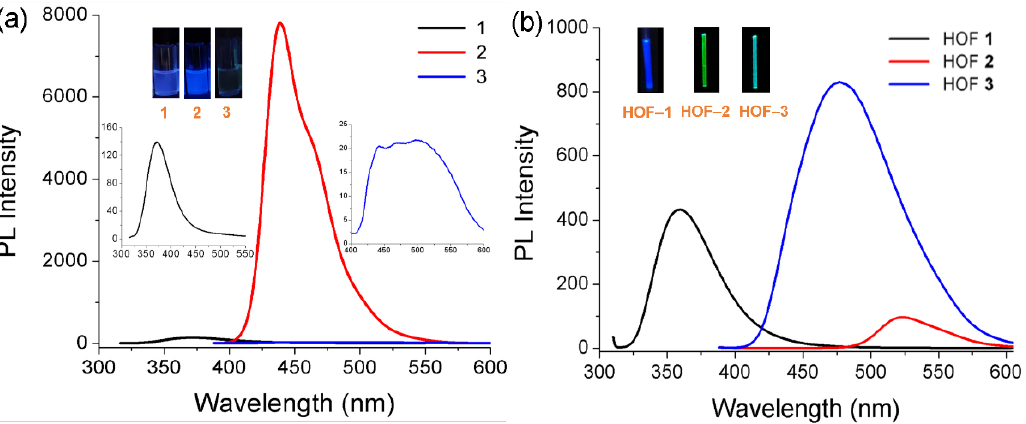
Figure 5. Emission spectra of 1 , 2 , and 3 and HOF-1 , HOF-2 , and HOF-3 . ( a ) PL spectra of 1 (black), 2 (red), and 3 (blue) in solution state (DMA). ( b ) PL spectra of HOF-1 (black), HOF-2 (red), and HOF-3 (blue) in crystalline state.